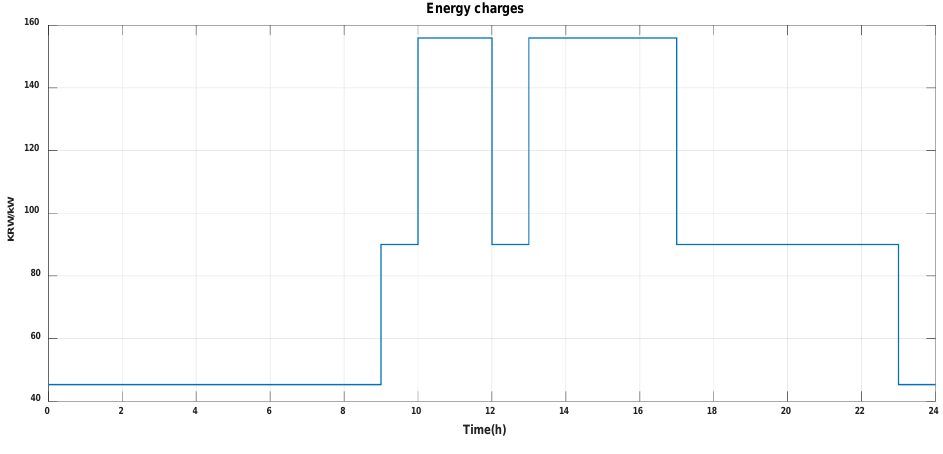
Figure 5. Energy charges.